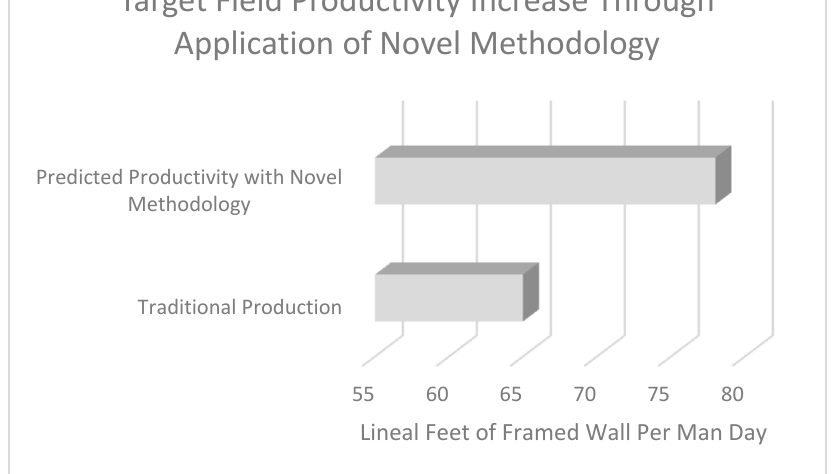
Figure 11. Traditional approach and predicted model output per worker per workday.